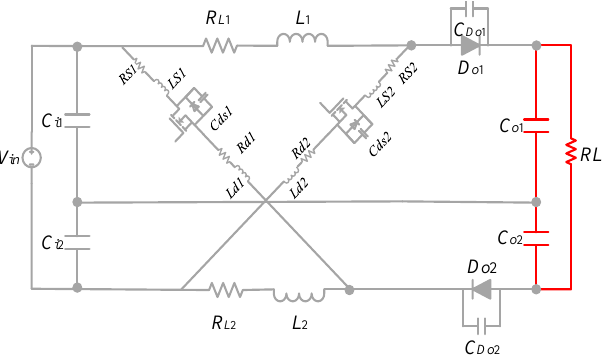
Figure 6. Equivalent circuit of Mode 3.